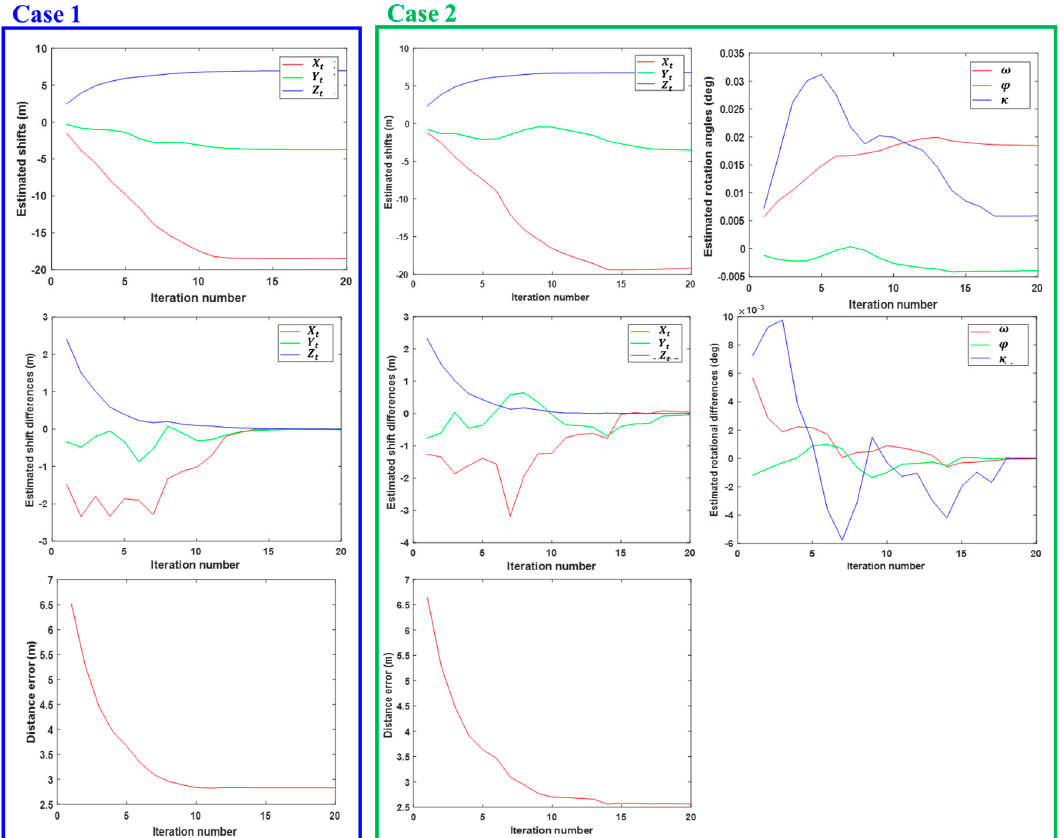
Figure 8. Convergence behaviour of the matching algorithm. The left and right columns illustrate the estimation process in case 1 (three translation parameters) and case 2 (three rotation angles and three translation parameters), respectively.